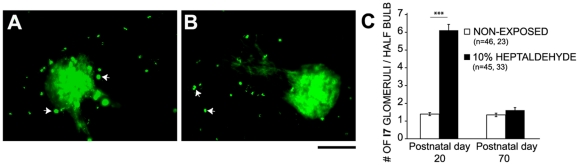
Adult mice were unable to form supernumerary glomeruli in response to chronic odorant exposure.Figures A and B show representative I7tauGFP glomeruli from non-exposed mice and from those exposed to 10% heptaldehyde, respectively; periglomerular neuron autofluorescence (arrows) is commonly seen in adults. Scale bar 100 µm. The bar graph in C depicts the average number of I7 glomeruli per half bulb in mice exposed during early postnatal stage (PD0–PD20) and in those exposed during adulthood (PD50–PD70). Mann-Whitney U test: ***, P<0.001.